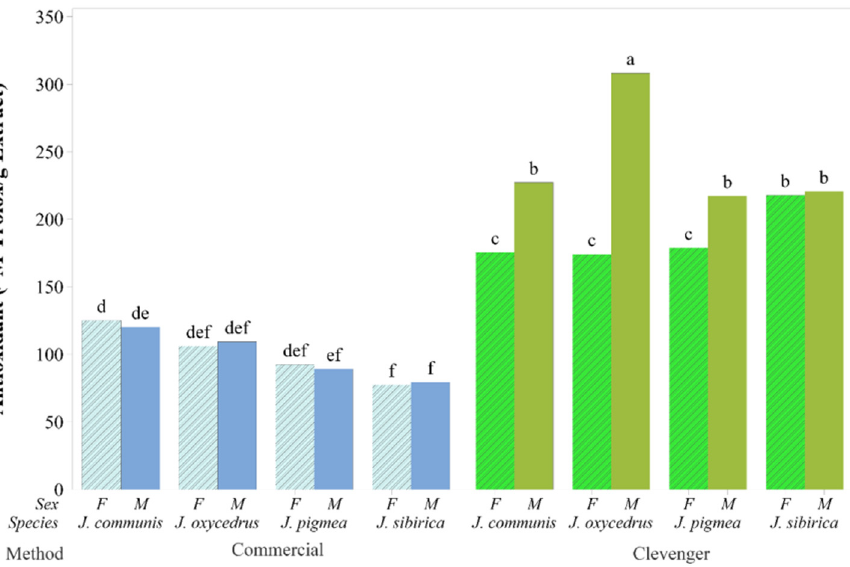
Figure 1. Bar graph of mean antioxidant capacity in µ mol Trolox g − 1 obtained from the 16 combina- tions of the extraction method, species and sex. Means sharing the same letter (at the top of the bars) are not significantly different.